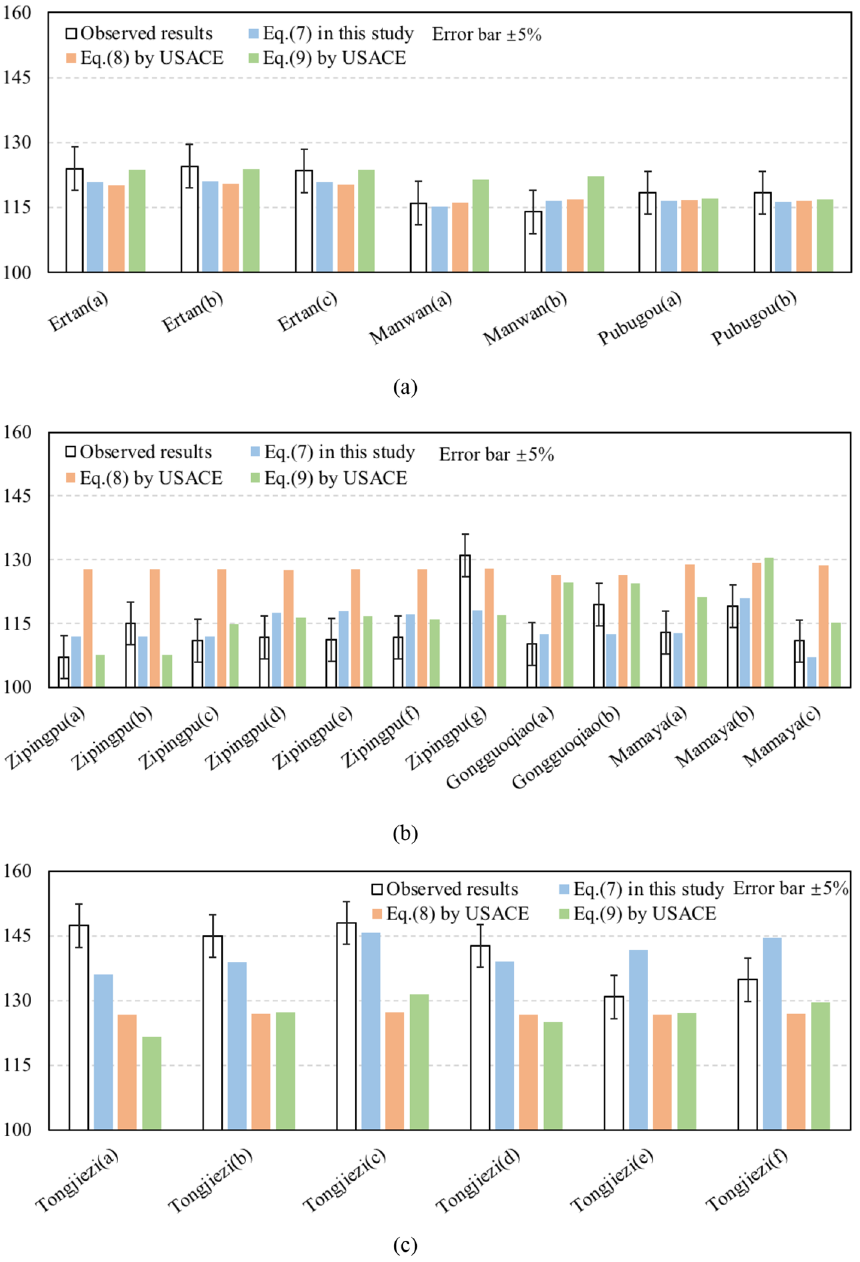
Figure 5. Computed TDG results by Eqs. (9), (10) and (11) compared to the observed TDG level at: ( a ) Ertan, Manwan, Pubugou projects; ( b ) Zipingpu, Gongguoqiao, Mamaya projects; ( c ) Tongjiezi